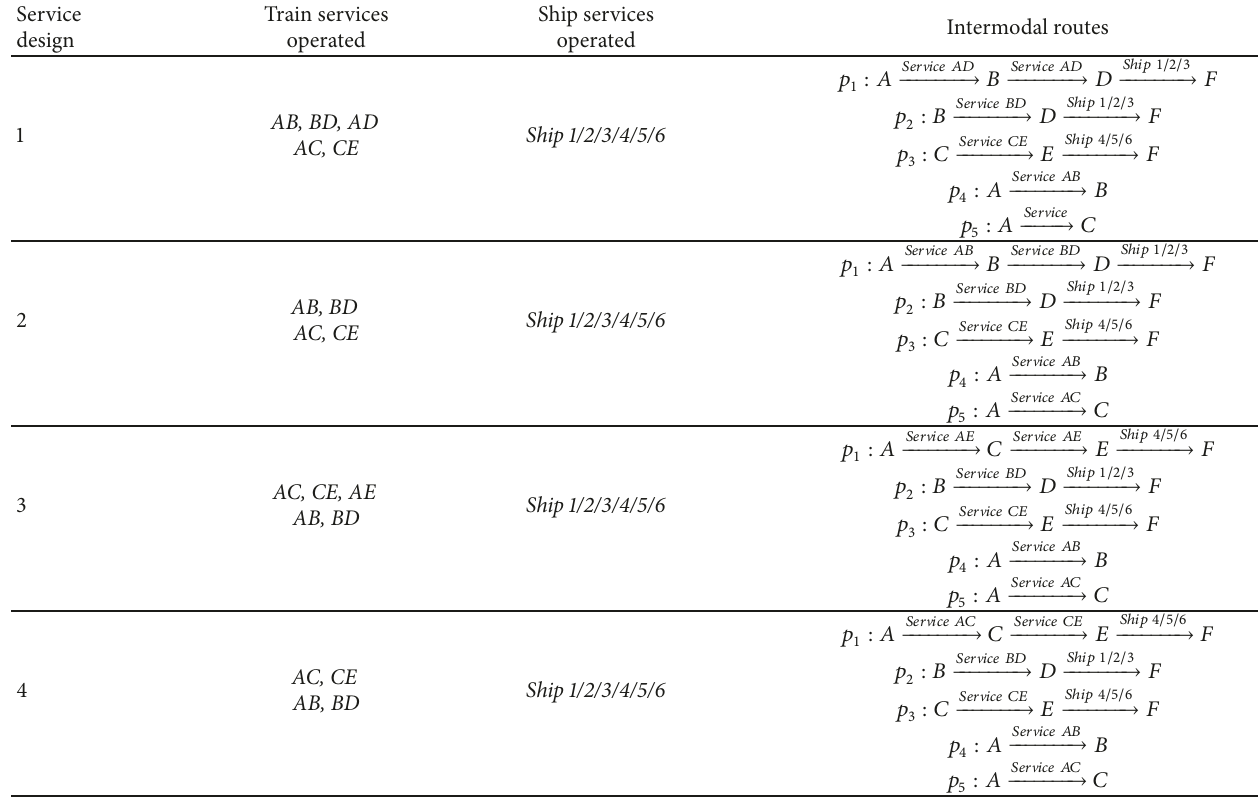
Table 2: Candidate service designs and intermodal routes for the network in Figure